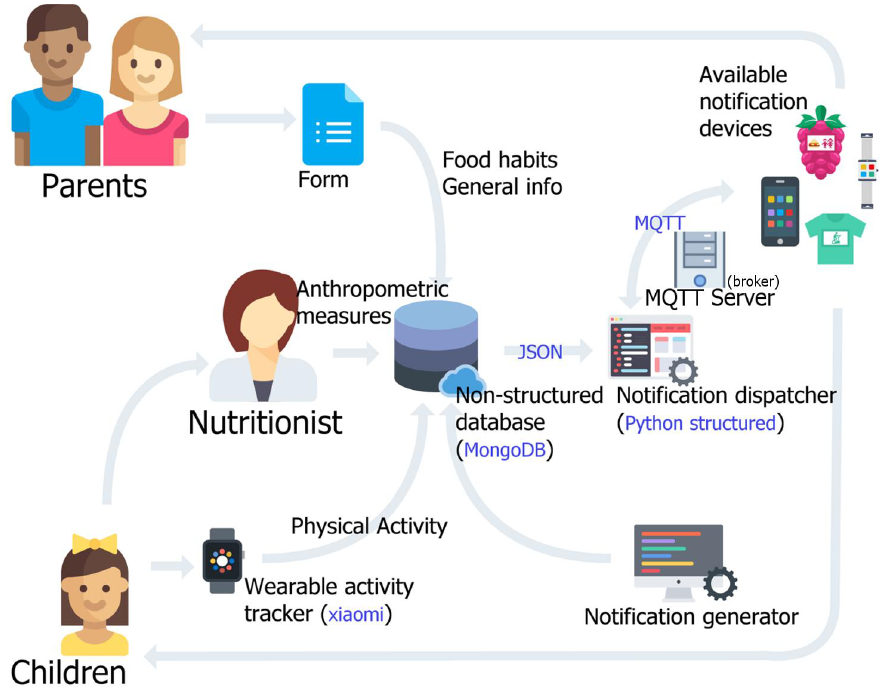
Figure 1. System overview including: main actors, software components, and technological infrastructure.